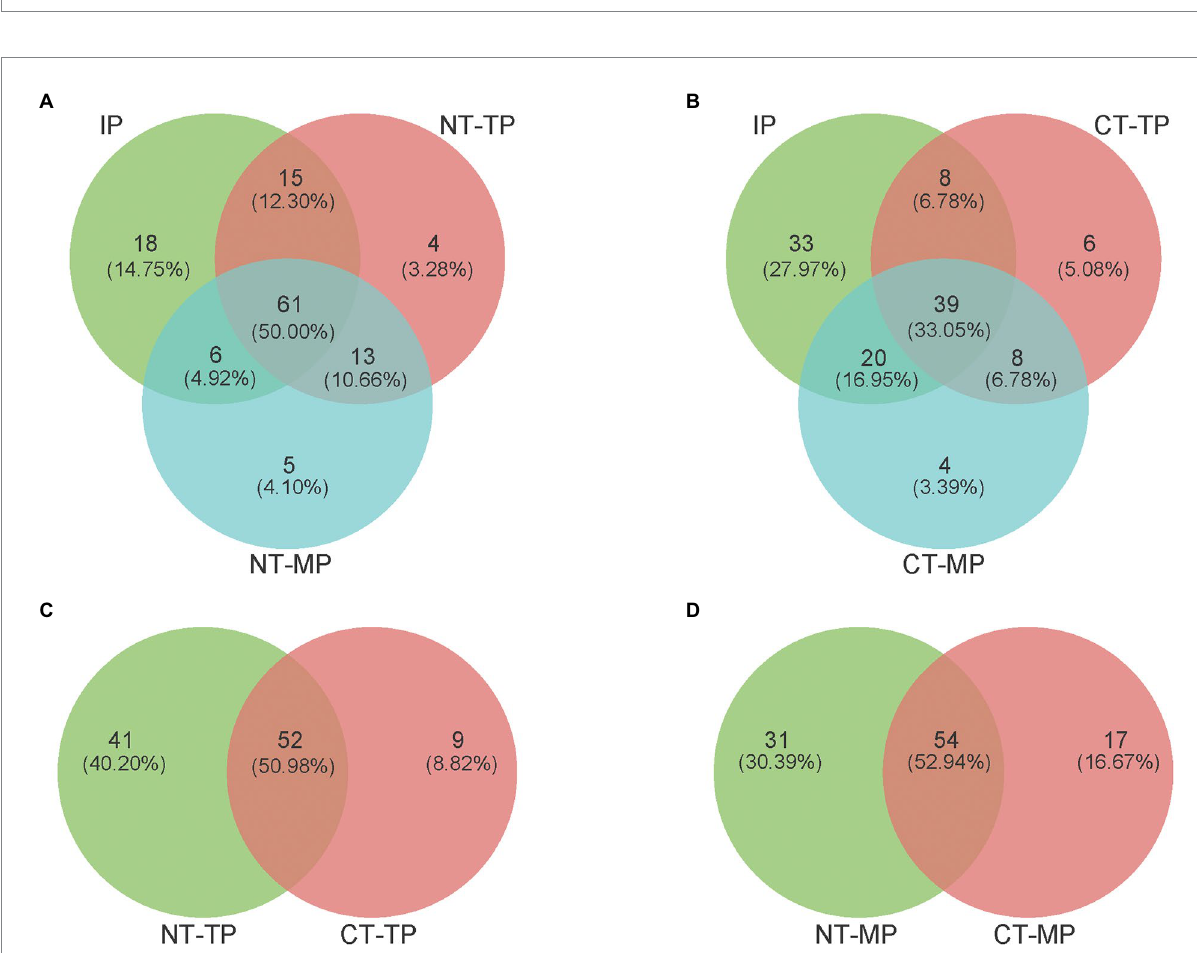
FIGURE 5 Venn diagrams reveal the shared and unique numbers of transconjugant pools for plasmid RP4 transferred at the genus level. (A,B) Show the number of shared and unique genera among the three composting phases (IP, TP, and MP) in the NT and CT, respectively. (C,D) Diagrams show the number of shared and unique genera between NT and CT at the end of the thermophilic and mature phase, respectively. NT and CT represent normal and continuous thermophilic composting, respectively; IP, TP, and MP represent the initial, thermophilic, and mature phases, respectively.